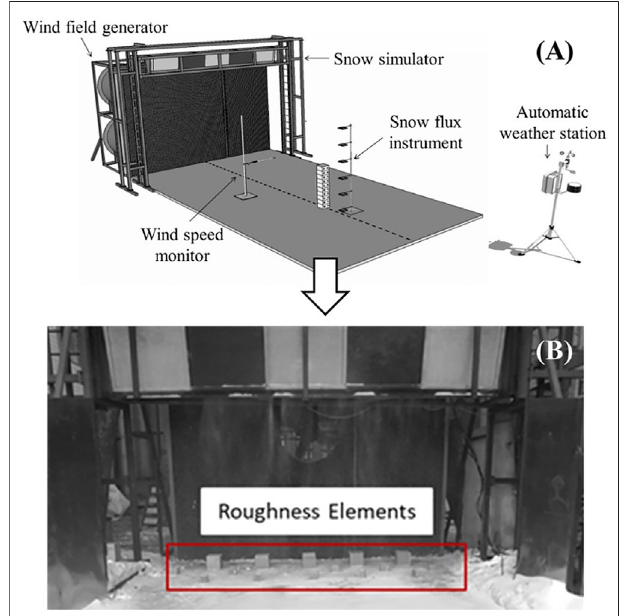
FIGURE 1 | Schematic view (A) and photo of the snow-wind combined experiment facility (B)